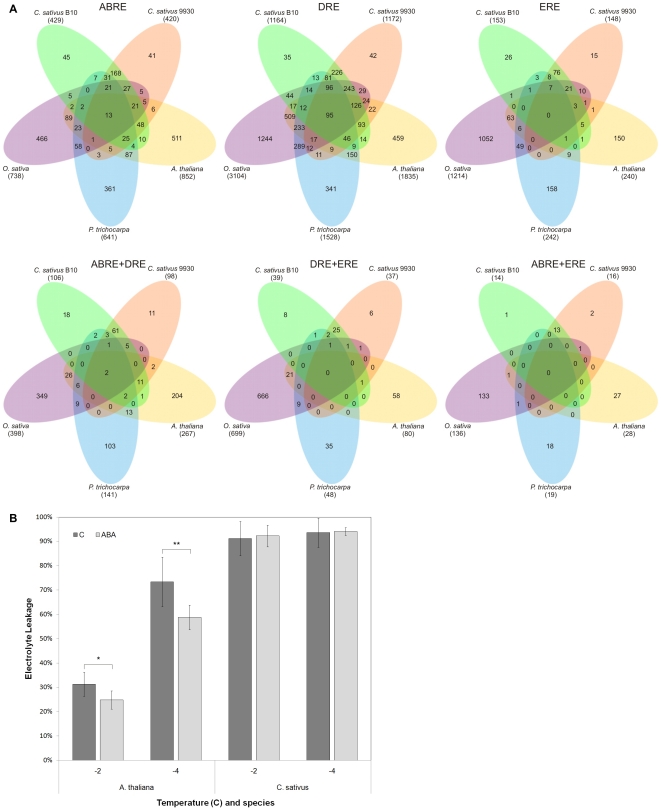
Comparison of CRE content in orthologous genes and freezing tolerance tests of non-acclimated A. thaliana and C. sativus seedlings after abscisic acid (ABA) treatment.(A) Venn diagrams presenting the number of common and different orthologous genes' groups (5,971) with respect to the occurrences of ABREs, DREs, EREs and their combinations in promoters in A. thaliana, P. trichocarpa, O. sativa and lines B10 and 9930 of northern European and Chinese C. sativus varieties. Total number of orthologous groups with specific CRE or combination of CREs is given in brackets. (B) Freezing tolerance tests of non-acclimated A. thaliana and C. sativus plants after ABA treatment. Leaves were frozen in different temperatures and cellular damage was assessed by measuring electrolyte leakage. Statistically significant difference was assessed by Student's t-test – n = 5, * p-Value<0.05; ** p-Value<0.005. Error bars indicate standard deviations. C – control non-treated plants; ABA – abscisic acid treated plants.